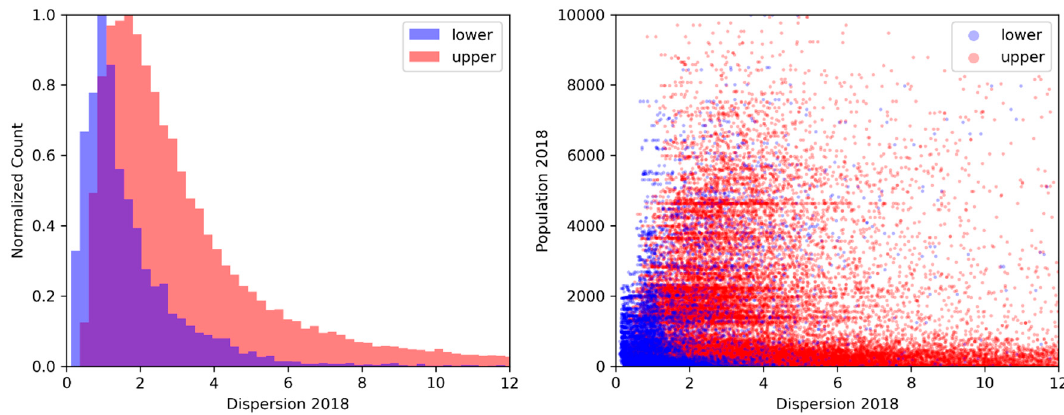
Figure 38. Histogram and scattergram of the 2018 dispersion values for the developing set (Harare, Nairobi, Dhaka, and Pyongyang) versus the developed set (Houston, Seoul, Shanghai, Beijing). The developed set is red and developing set is blue. The two sets are referred to as “lower” and “upper”, respectively. The sample set excludes grid cells deemed to be permanent background, where no lighting is detected. The scattergram is the dispersion versus population count from 2018.